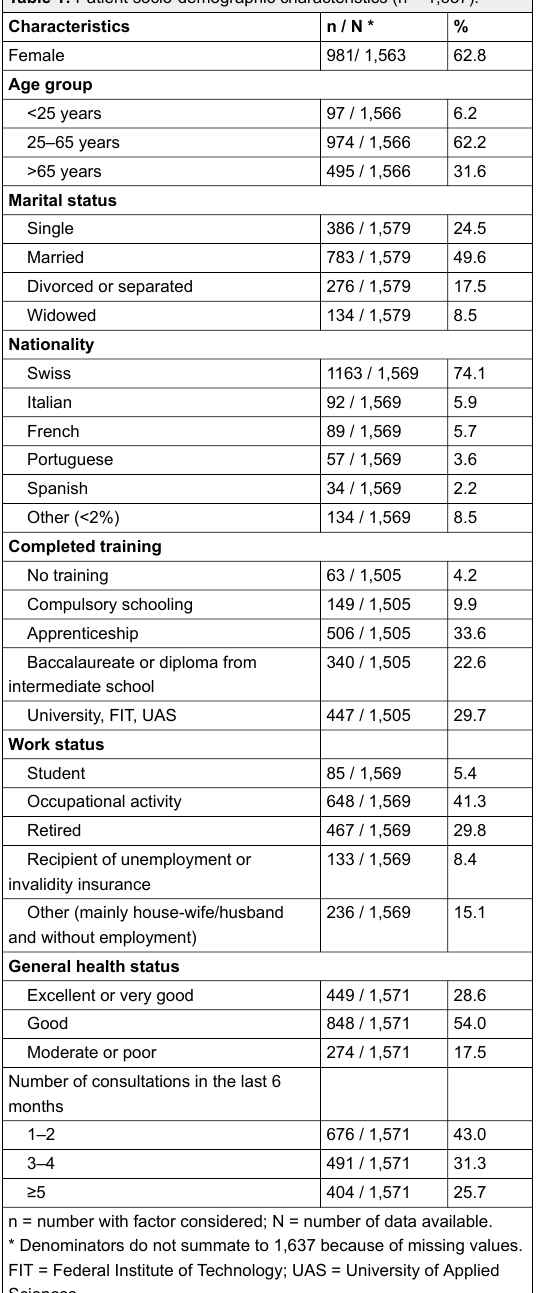
Table 1: Patient socio-demographic characteristics (n = 1,637).